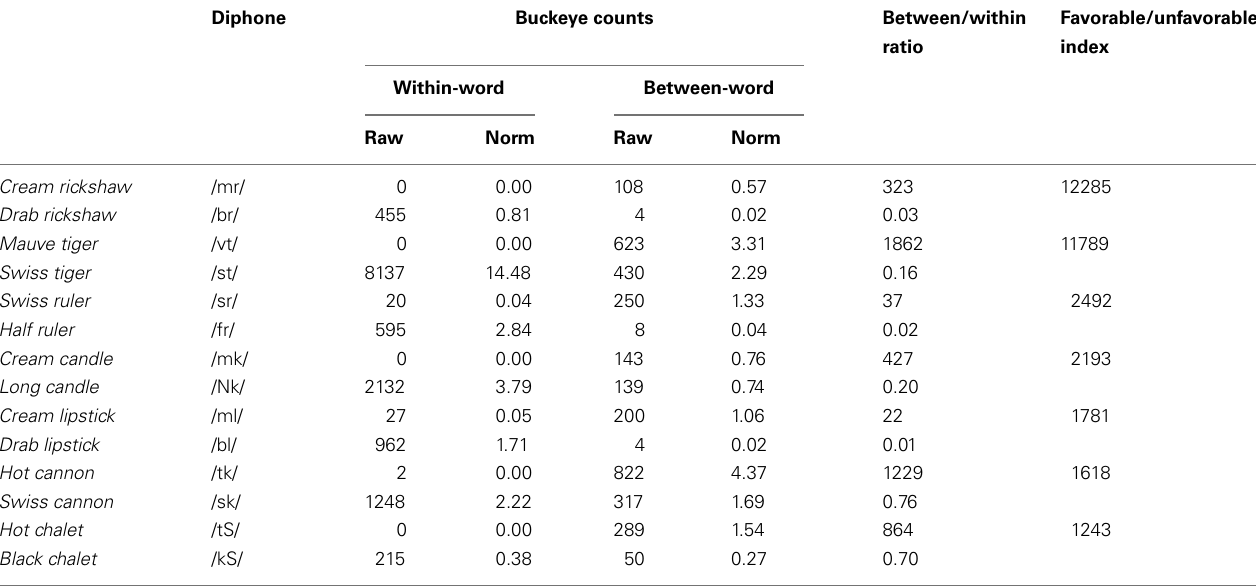
Table 2 |Within-word and between-word diphone statistics calculated from the Buckeye corpus for the segmentation-favorable and segmentation-unfavorable diphone pairs in the phonotactics condition.